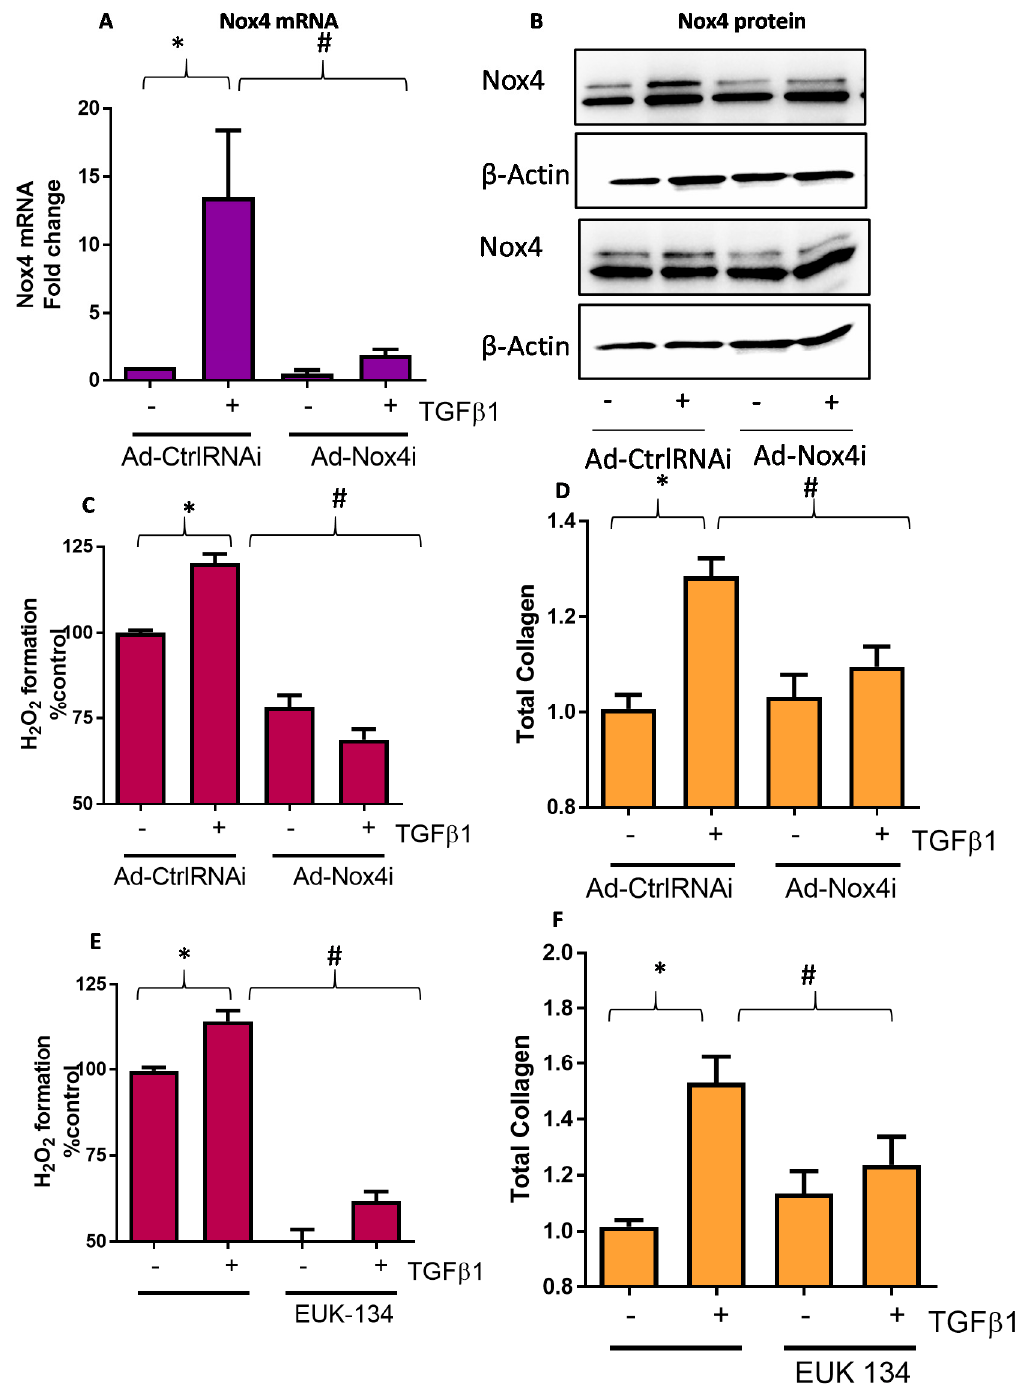
Figure 3. Effect of Nox4 inhibition and EUK-134 on H 2 O 2 and collagen production in human Tenon’s fibroblasts (HTFs). Treatment of HTF with Ad-Nox4i inhibited the stimulatory effects of TGF β 1 (5 ng/mL) on expressions of both Nox4 ( A ) gene and ( B ) protein at 6 h, ( C ) generation of H 2 O 2 at 6 h, and ( D ) total collagen at 24 h. Similarly, H 2 O 2 scavenger EUK-134 (25 μ M) inhibited TGF β 1-induced ( E ) H 2 O 2 formation and ( F ) total collagen production. All data are mean ± SEM from three to six independent experiments, * p < 0.05 from control without treatment; # p < 0.05 from treated cells with TGF β 1. 3.4. Nox4 and H 2 O 2 Generation Is Involved in TGF β 1-Induced Proliferation of HTFs